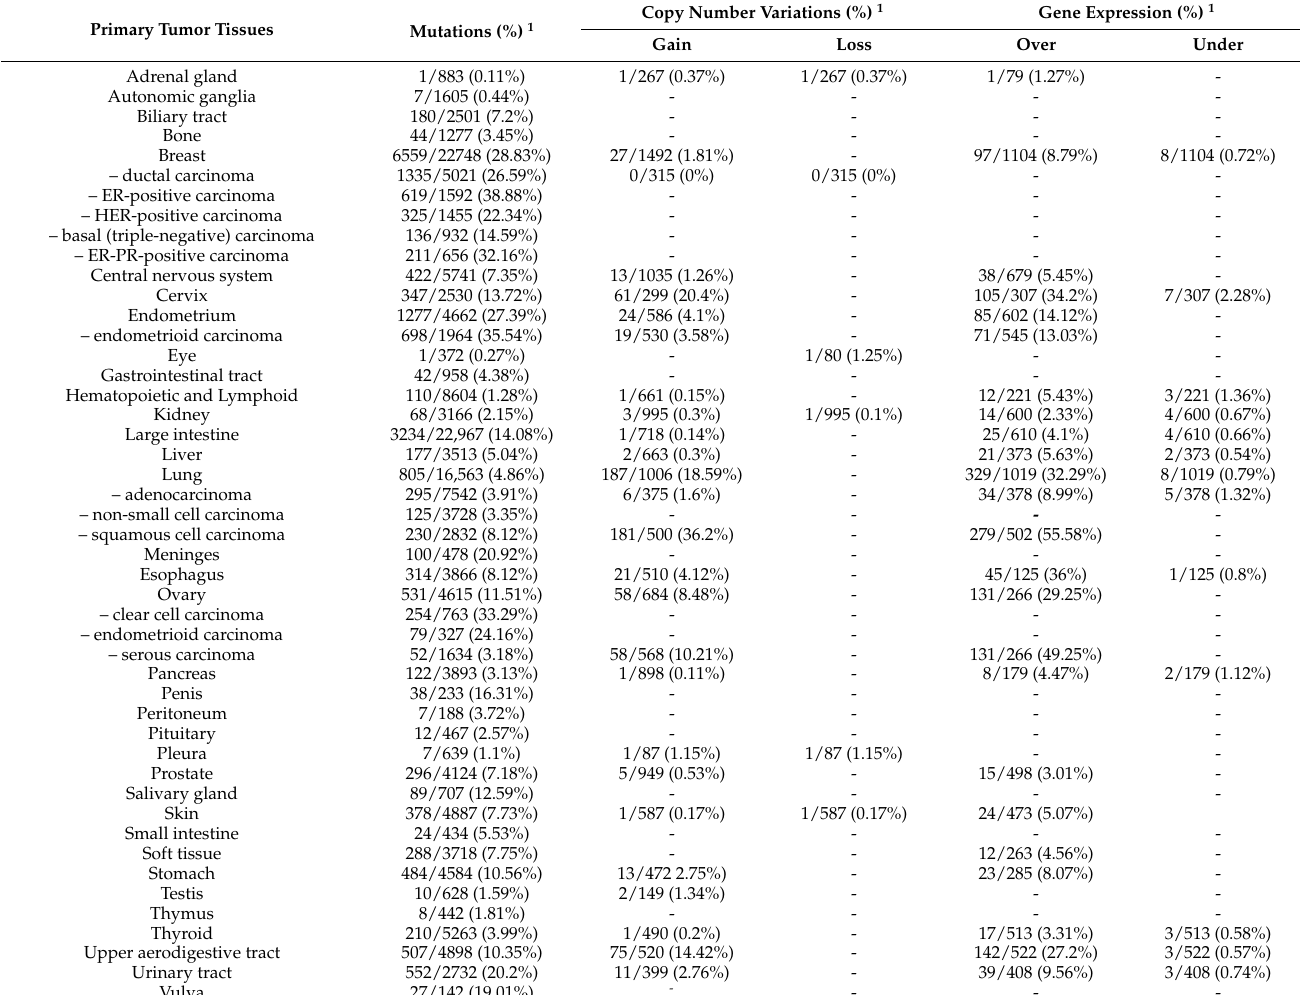
Table 1. Genetic alterations of the PIK3CA gene in human cancers. HER: human epidermal growth factor receptor; Primary Tumor